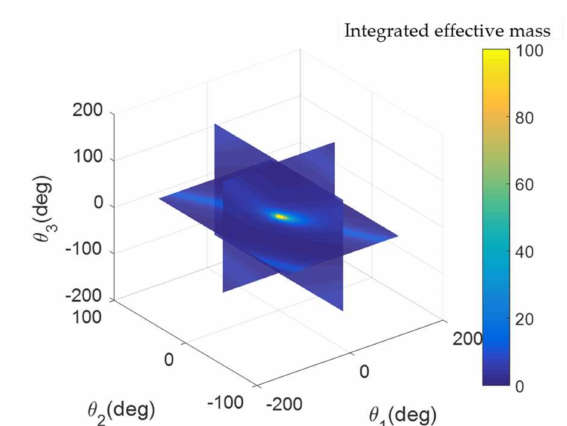
Figure 9. Slice map at θ 1 = 0 deg, θ 2 = 0 deg and θ 3 = 0